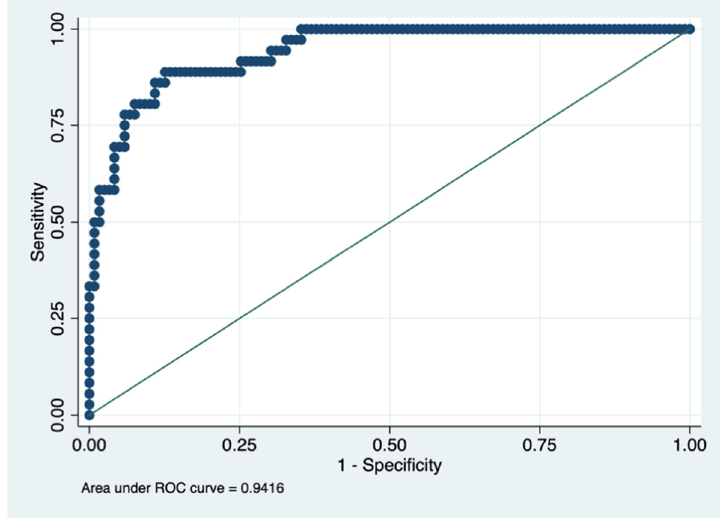
Figure 2. Predictive capacity for the cut-off point >40 points for the PDQ-39 questionnaire (area under the ROC curve (AUROC)). Figure legend. AUROC to determine the predictive ability of the model in the validation cohort, representing the sensitivity on the y-axis and specificity on the x-axis.